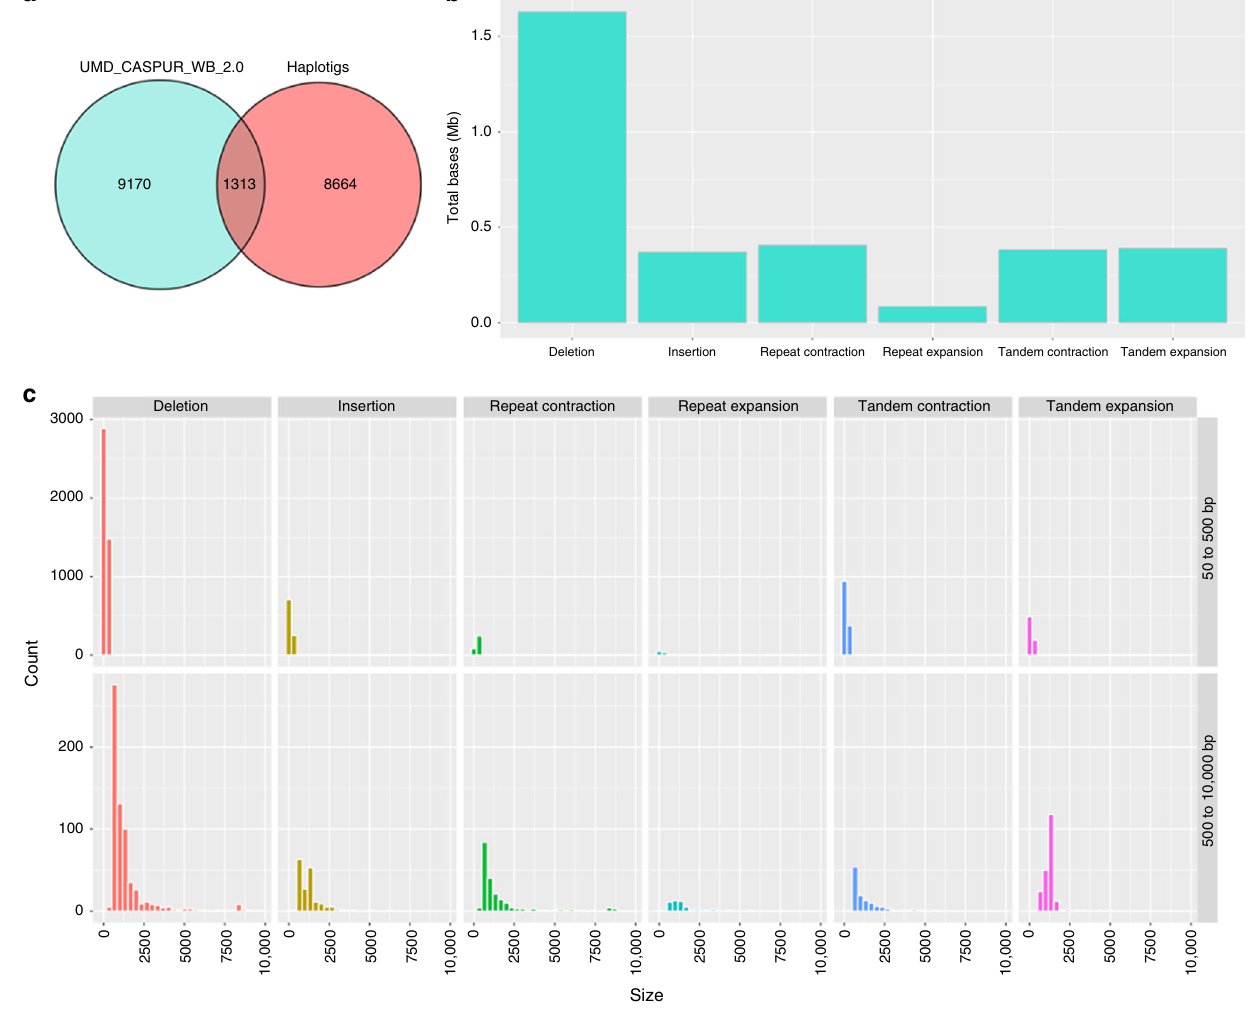
Fig. 3 Structural differences between UMD_CASPUR_WB_2.0 and UOA_WB_1. a Venn diagram of structural differences called in UMD_CASPUR_WB_2.0 and haplotigs when UOA_WB_1 was used as the reference. The 8664 unique and 1313 overlapping differences in haplotigs represent heterozygous alleles. Structural differences present only in UMD_CASPUR_WB_2.0 are likely assembly errors. b Total bases of structural differences in categories deletion, insertion, repeat contraction, repeat expansion, tandem contraction, and tandem expansion. For example, for deletion, we report the number of bases found in UOA_WB_1 but missing in UMD_CASPUR_WB_2.0. c Count of structural differences in the categories from part b, partitioned by